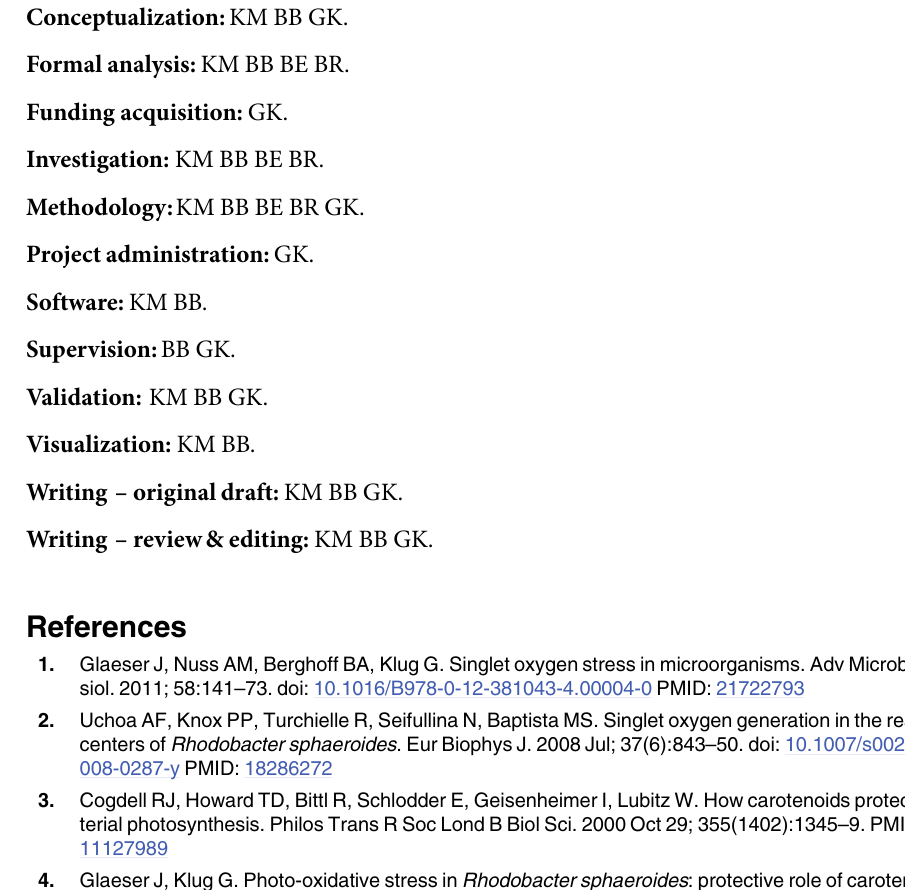
S1 Table. Genes which are down-regulatedupon Pos19 over-expression with a log2 ratio (cid:20)